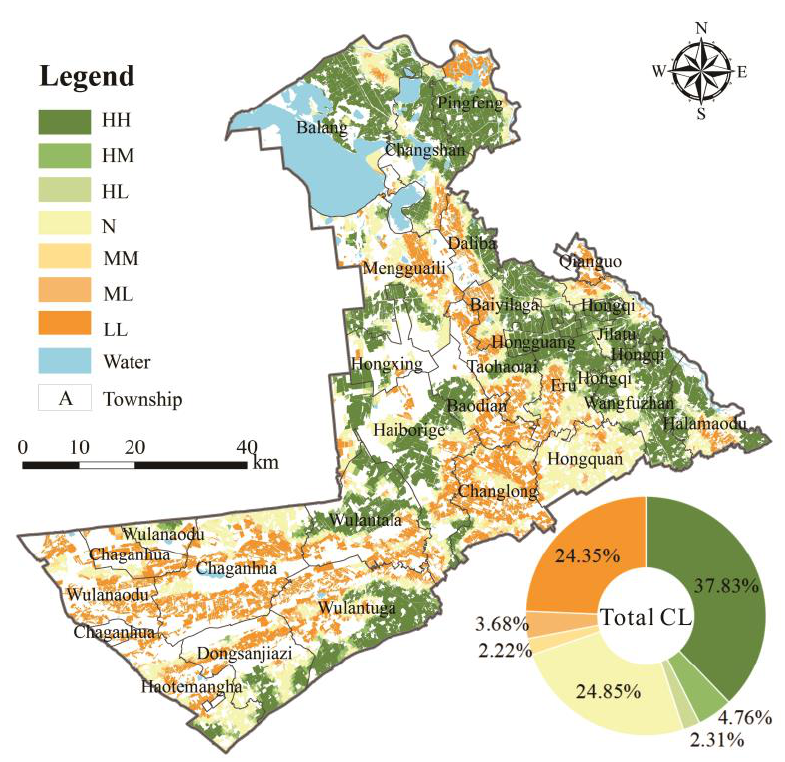
Figure 7. Spatial cluster pattern of LESA score.